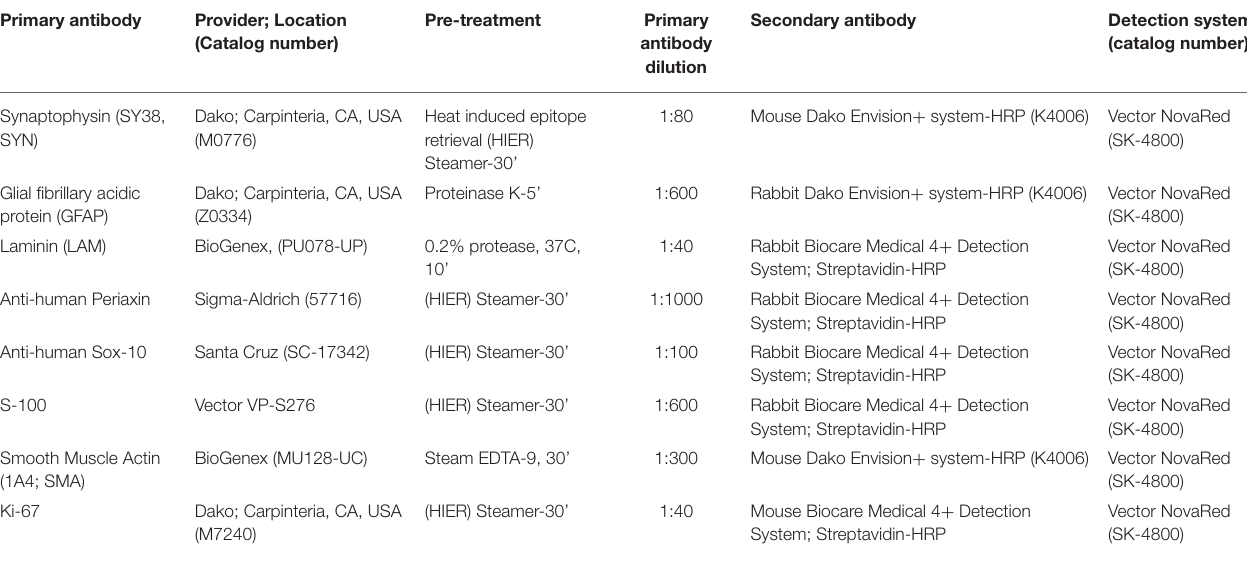
TABLE 1 | Panel of antigenic markers used by immunohistochemistry. Primary antibody Provider; Location (Catalog